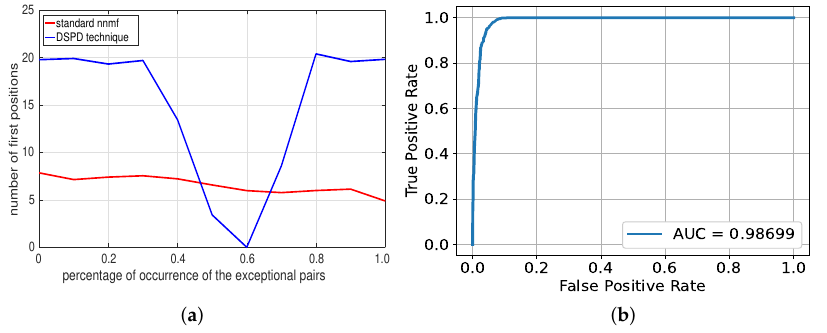
Figure 3. Experiments on real data. ( a ) Behavior of discriminative pairs. ( b ) Behavior on known